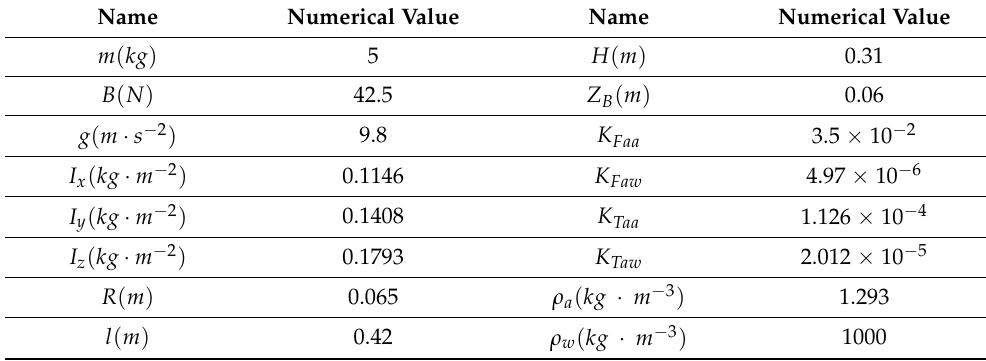
Table 4. Simulation parameters.